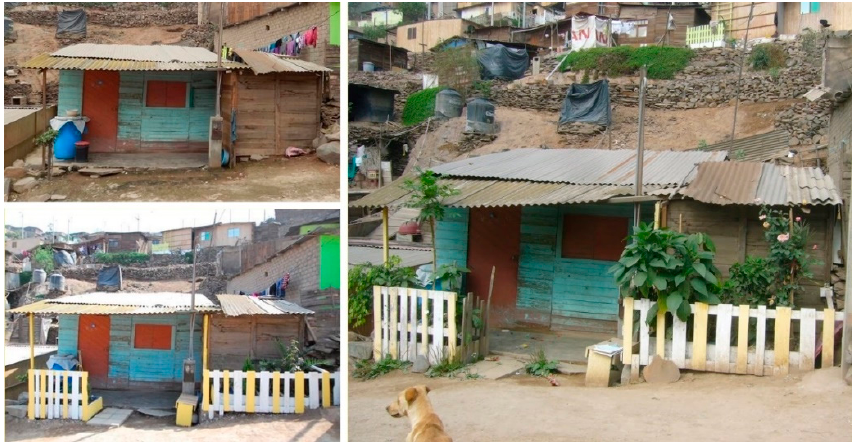
Figure A1. Example 1: Garden progression over a 6 ‐ months period.